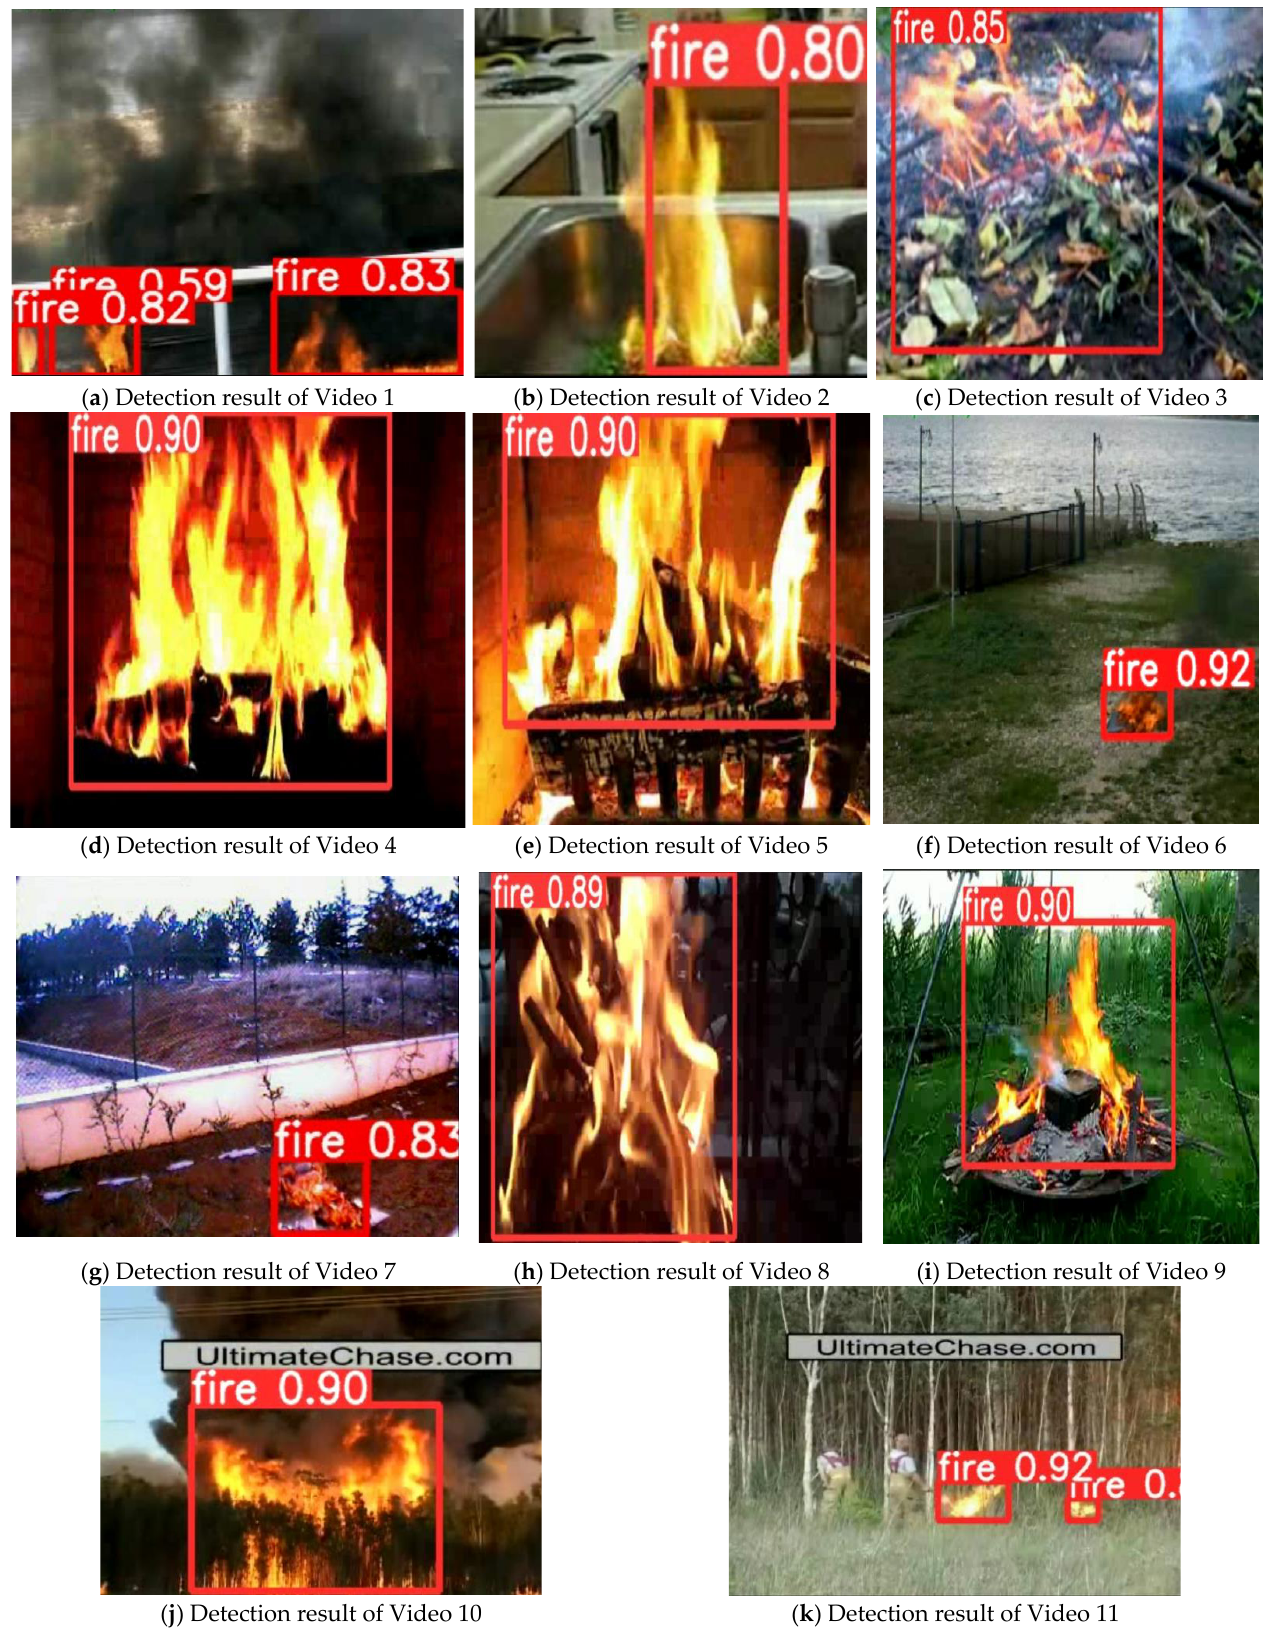
Figure 15. Slicing of the public fire video dataset VisiFire detection results. ( a – k ) are slices of the results of detecting the 1st to 11th fire videos in VisiFire,